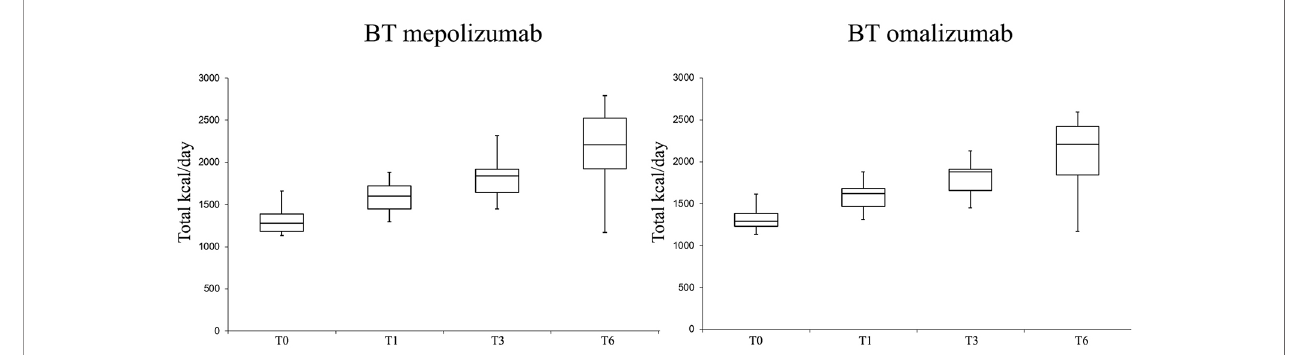
FIGURE 4 | Total EE (estimated energy expenditure) variation at different follow-ups in the biologic therapy (BT) omalizumab group and in the BT